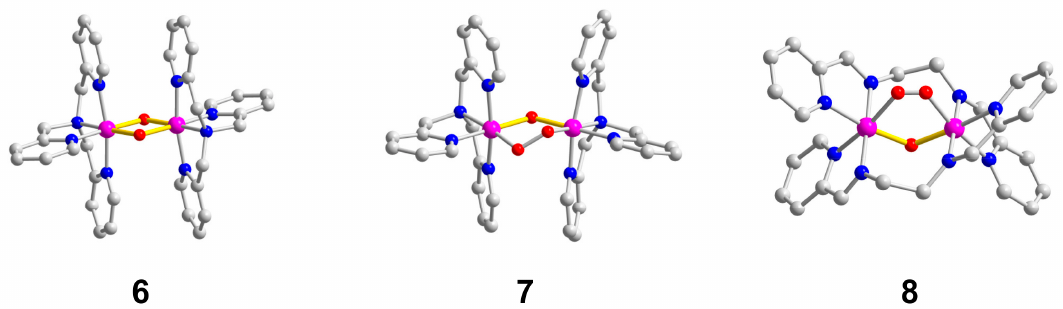
Figure 3. Structures of complexes 6 – 8 . Color scheme: Co, pink; O, red; N, blue; S, yellow; C, grey. Co–O–Co bonds are highlighted by yellow.